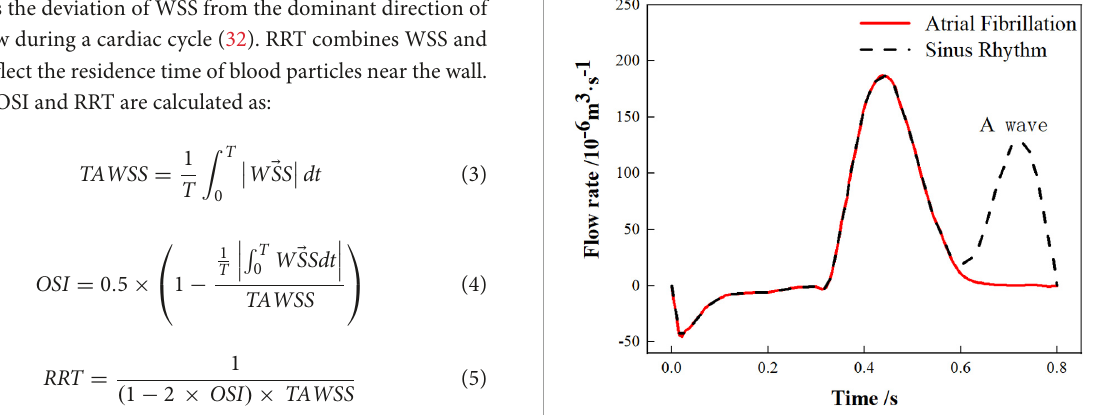
difference of the